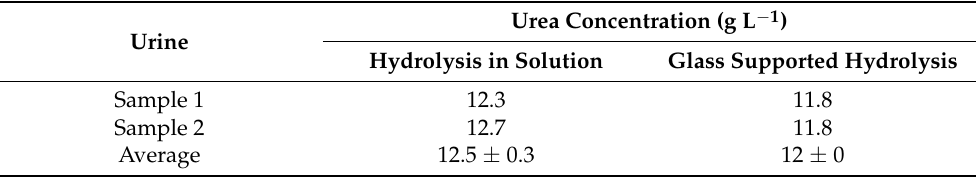
Table 5. Urea concentration found in hydrolyzed urine samples. Experimental scheme: Hydrolyzed urea → dilution → sensor